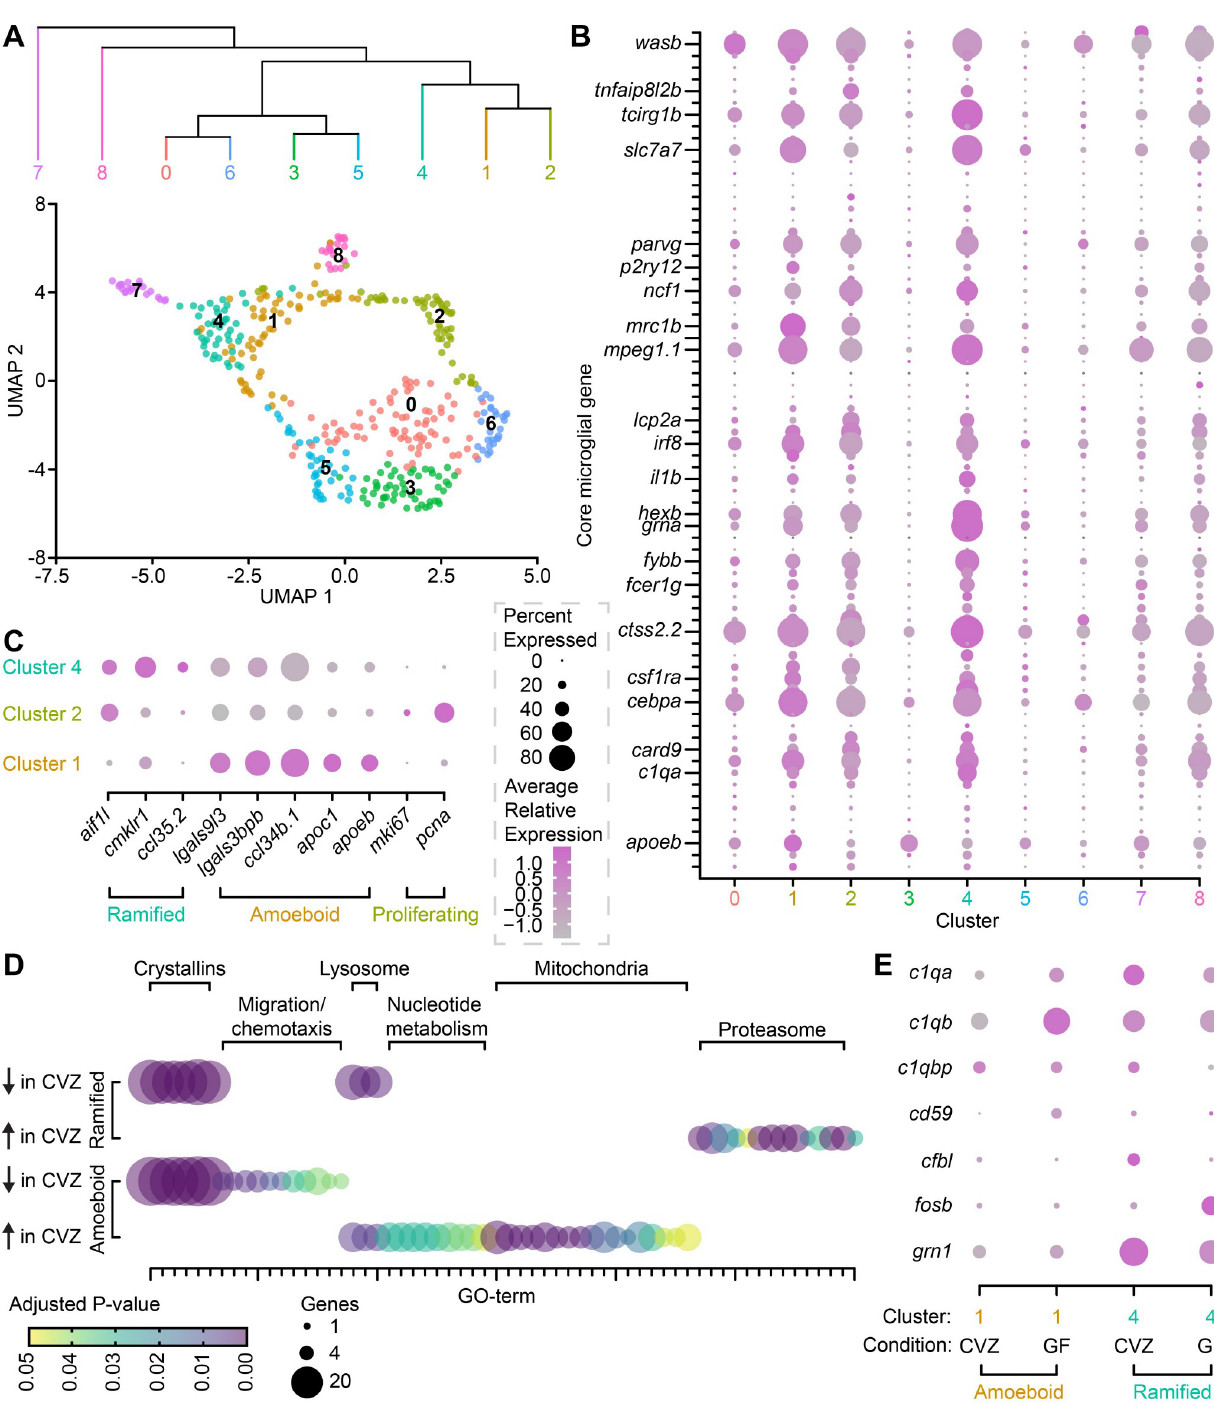
Fig 6. The microbiota influences microglial gene expression. ( A ) UMAP visualization and hierarchical clustering of immune cells from mpeg1 . 1 + Cluster 36 in Massaquoi and colleagues [62]. ( B ) Average relative expression level (color) and percent of clustered cells (dot size) expressing each member of a 75-gene microglial fingerprint across 9 clusters of mpeg1 . 1 + Cluster 36 immune cells. Select transcripts are labeled and the complete fingerprint is included in S1 Table. ( C ) Average relative expression level (color) and percent of clustered cells (dot size) expressing ramified, amoeboid, and proliferative microglial markers in clusters 1, 2, and 4. ( D ) Number of included genes (dot size) and adjusted P value (color) for gene ontology (GO) terms expressed in ramified microglia (cluster 4, top) and amoeboid microglia (cluster 1, bottom). GO term identities are included in S2 Table. ( E ). Average relative expression level (color) and percent of amoeboid (cluster 1, orange) or ramified (cluster 4, teal) cells (dot size) from CVZ or GF larvae that express complement pathway transcripts. Data underlying this figure are available on figshare: https://figshare.com/projects/Bruckner_et_al_Data/136756 and in S1–S5